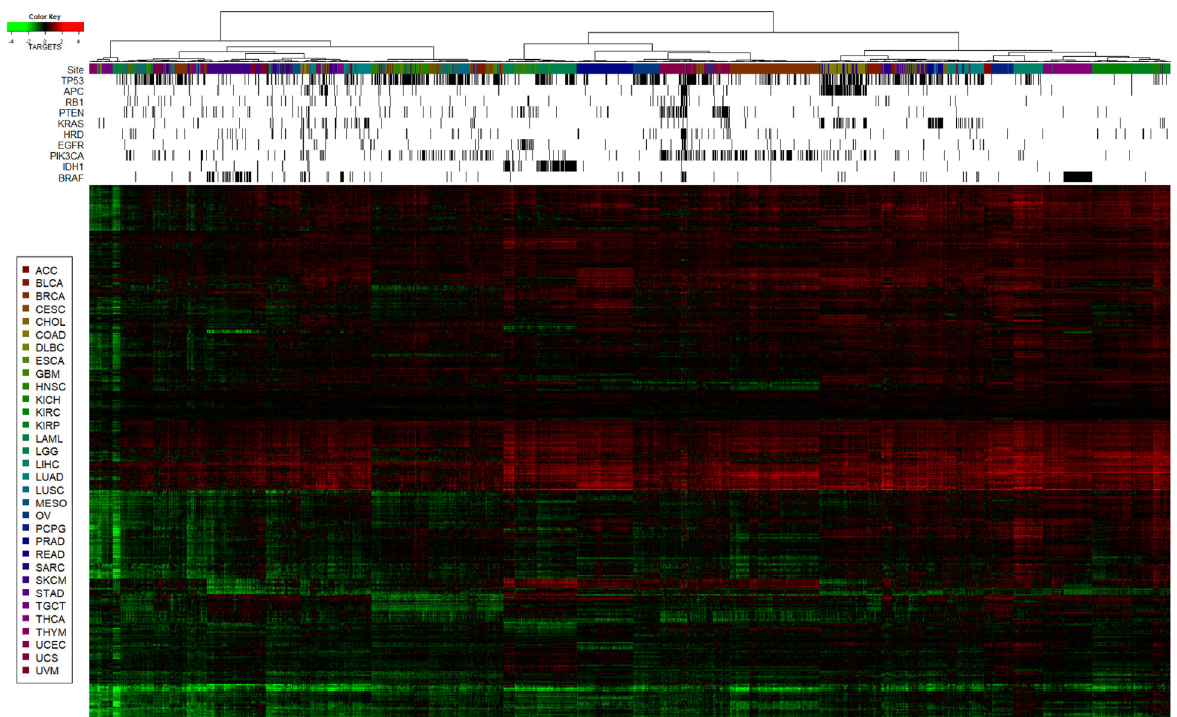
Fig. 2 TARGETS Scores in TCGA patients. TARGETS predictions for all drugs (rows) across all samples in the TCGA (columns) are shown in heatmap form. Hierarchical clustering was performed on both rows and columns. A lower TARGETS score indicates predicted sensitivity. Cancer site and type is identi fi ed using the TCGA standardized study